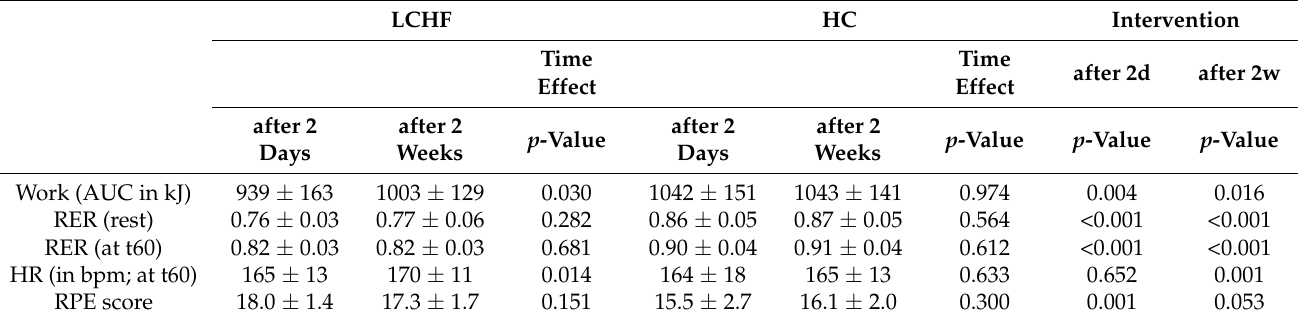
Table 3. Work, RER, HR and RPE. LCHF HC Intervention Time Effect